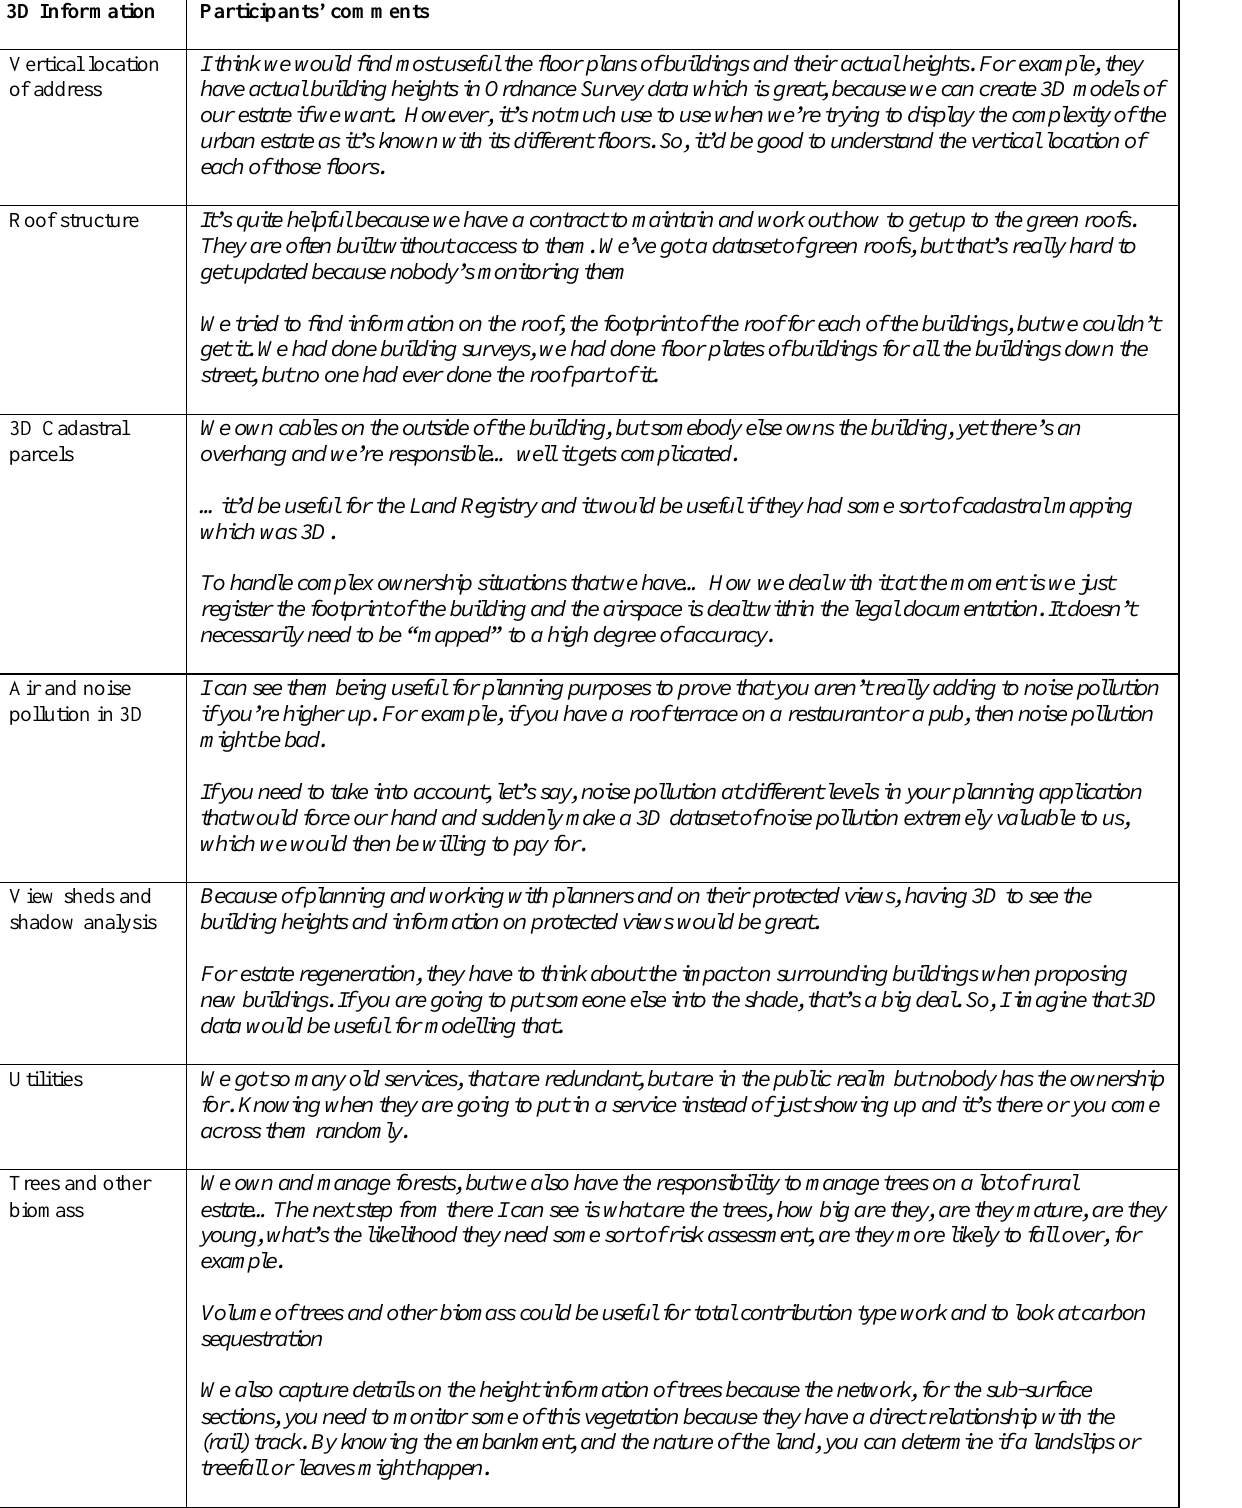
Table 1. Potential uses of and user requirements for 3D geographic